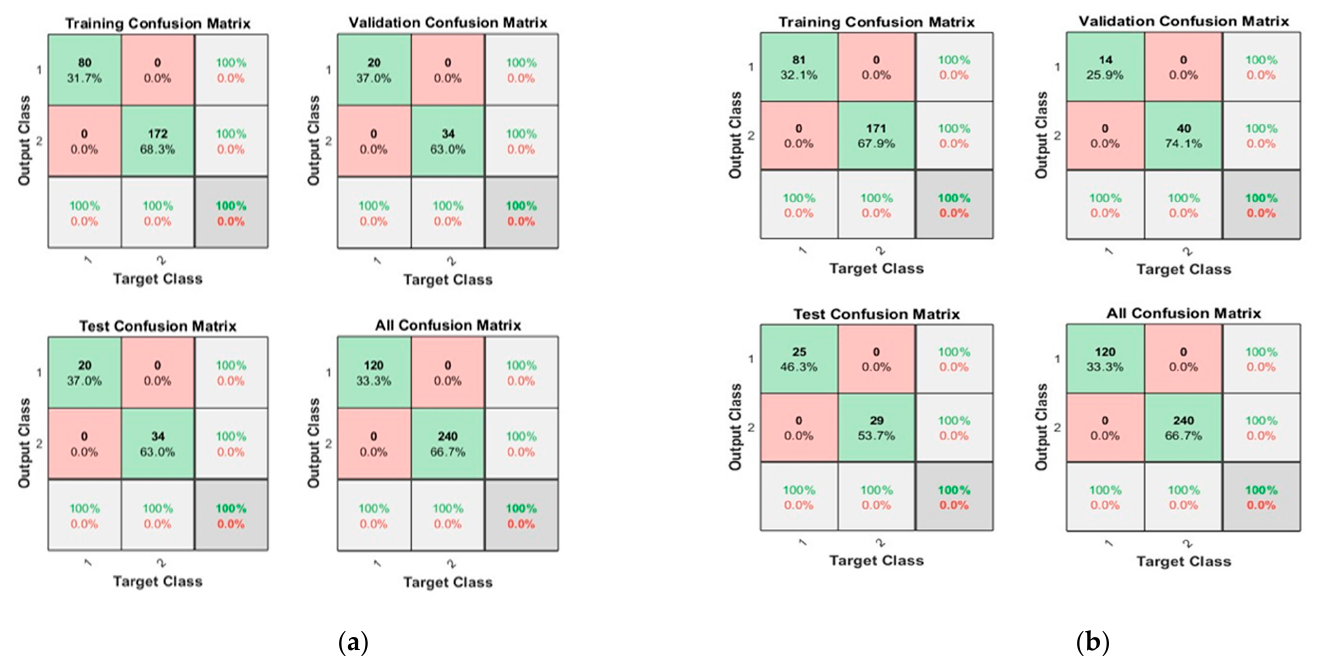
Figure 11. Confusion matrices of Dataset-3, where class label 1 shows the Normal operating condi- tions and class label 2 shows the Leak operating conditions of the pipeline using ( a ) 10 Neurons and ( b ) 50 Neurons.